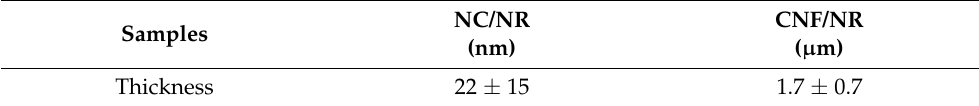
Table 2. Dimension of dispersed NC in NC/NR and CNF aggregates in